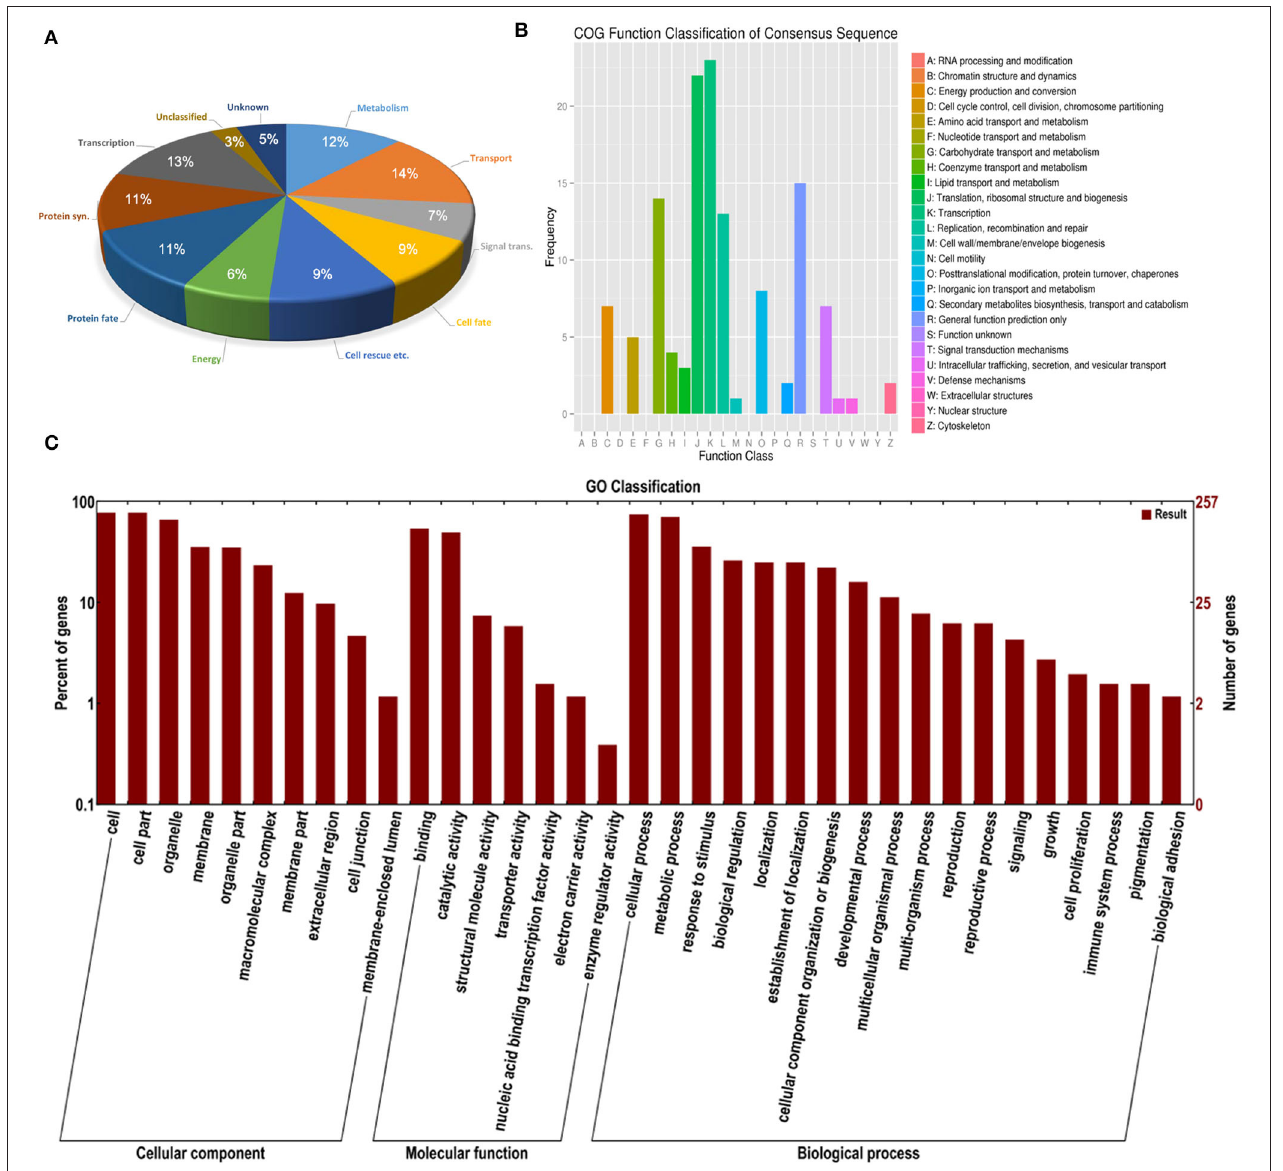
FIGURE 12 | Distribution of differentially expressed TDFs in the cDNA-AFLP analysis during seedling development under salt stress in S. aralocaspica . (A) BLAST functional classification, (B) KEGG functional cluster, and (C) GO functional classification. “Signal trans.” represents signal transduction, “Cell rescue etc. “represents cell rescue, defense and virulence; “Protein syn.” represents protein